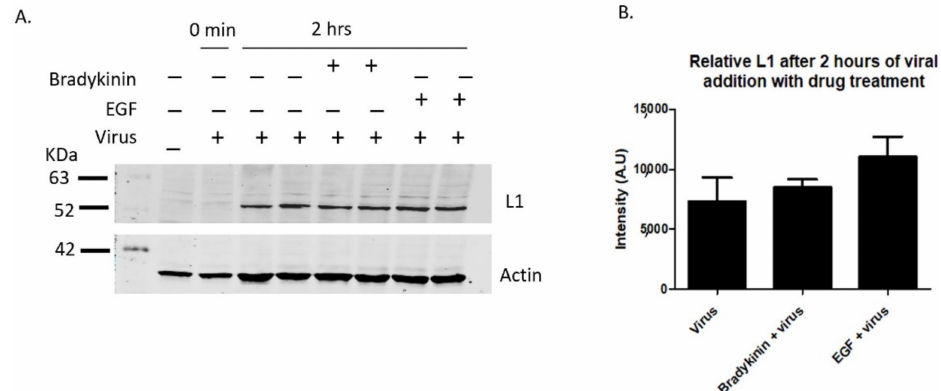
Figure 3. Bradykinin and EGF treatments show increased viral binding. L1 viral capsid protein was measured via western blot after the incubation of 200 ng/mL bradykinin and EGF. PsVs were added for 0 min or 2 h with samples incubated with or without drug on ice. HaCaT cells were washed three times with 1 × PBS and then harvested with trypsin. ( A , 1st lane) control sample without PsVs and drug, ( A , 2nd lane) control sample with virus that were immediately washed off, ( A , 3rd and 4th lane) control infection after 2 h, ( A , 5th and 6th lane) cells treated with bradykinin and virus for 2 h, ( A , 7th and 8th lane) cells treated with EGF and virus for 2 h. ( B ) Densitometry data of western blot in A showing the relative intensity of L1 protein normalized to actin for two samples from different wells for each treatment with either virus or virus and